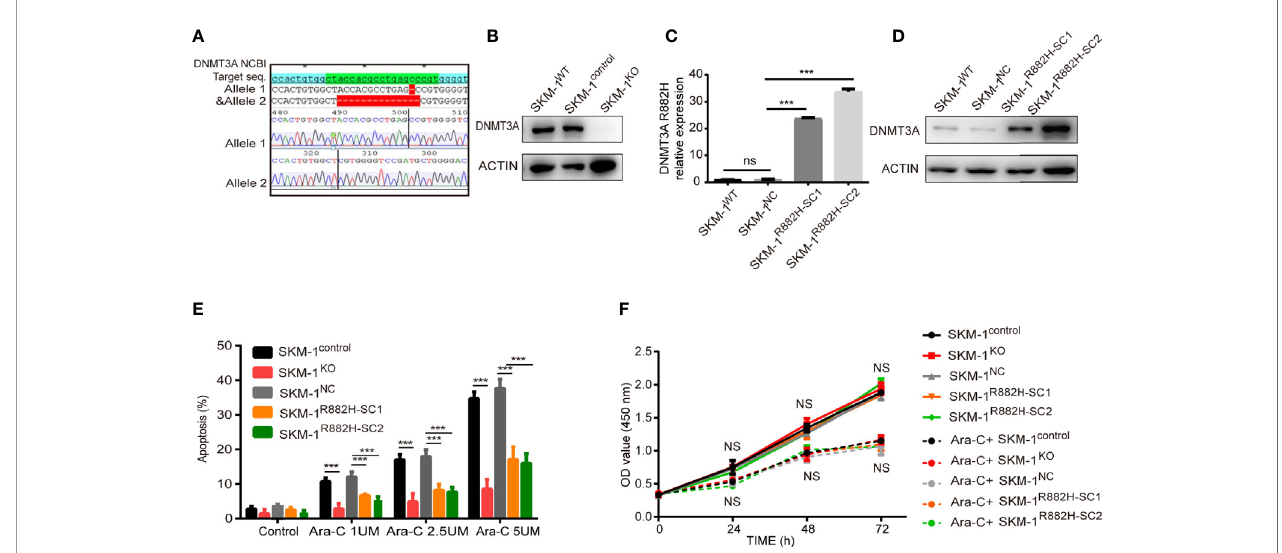
FIGURE 1 | The construction of DNMT3A knockout (KO) cells and DNMT3A-R882H mutant cells. (A) -1 and -14 frameshift mutations in the DNMT3A allele sequence of SKM-1 KO monoclonal cells. (B) SKM-1 KO cells did not express DNMT3A. (C, D) DNMT3A-R882H mRNA and protein expression levels in the constructed SKM-1 R882H SC1 and SKM-1 R882H SC2 clones. (E) SKM-1 KO and SKM-1 R882H cells were more resistant to cytarabine than the control group (SKM-1 NC ). (F) CCK8 assay showed no signi fi cant difference in proliferation of SKM-1 R882H , SKM-1 KO , SKM-1 control , and SKM-1 NC cells before and after 1 µM cytarabine treatment. All the results are presented as mean ± standard deviation of three independent experiments (n = 3). ***p < 0.0001 represent signi fi cant differences compared with the control. ns, no signi fi cance.